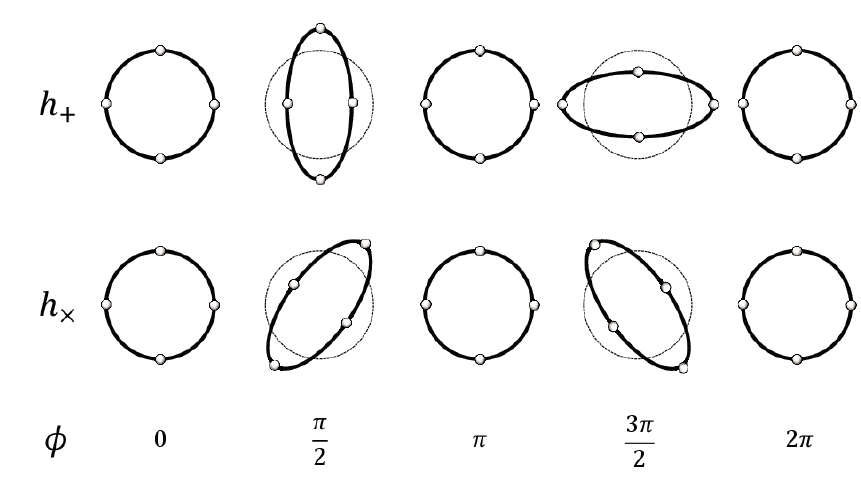
Figure 1. The effect of the passage of the linearly polarised gravitational wave through the ring of particles in the direction orthogonal to the plane is depicted in this figure. The circle shrinks in one direction and expands in the orthogonal direction during the crest and vice versa during the trough. This effect occurs along the directions oriented 45 ◦ with respect to one another for plus and cross polarizations denoted by h + and h × , respectively. (Image credit: Eur. Phys. J. Plus 132 (2017) no. 1,